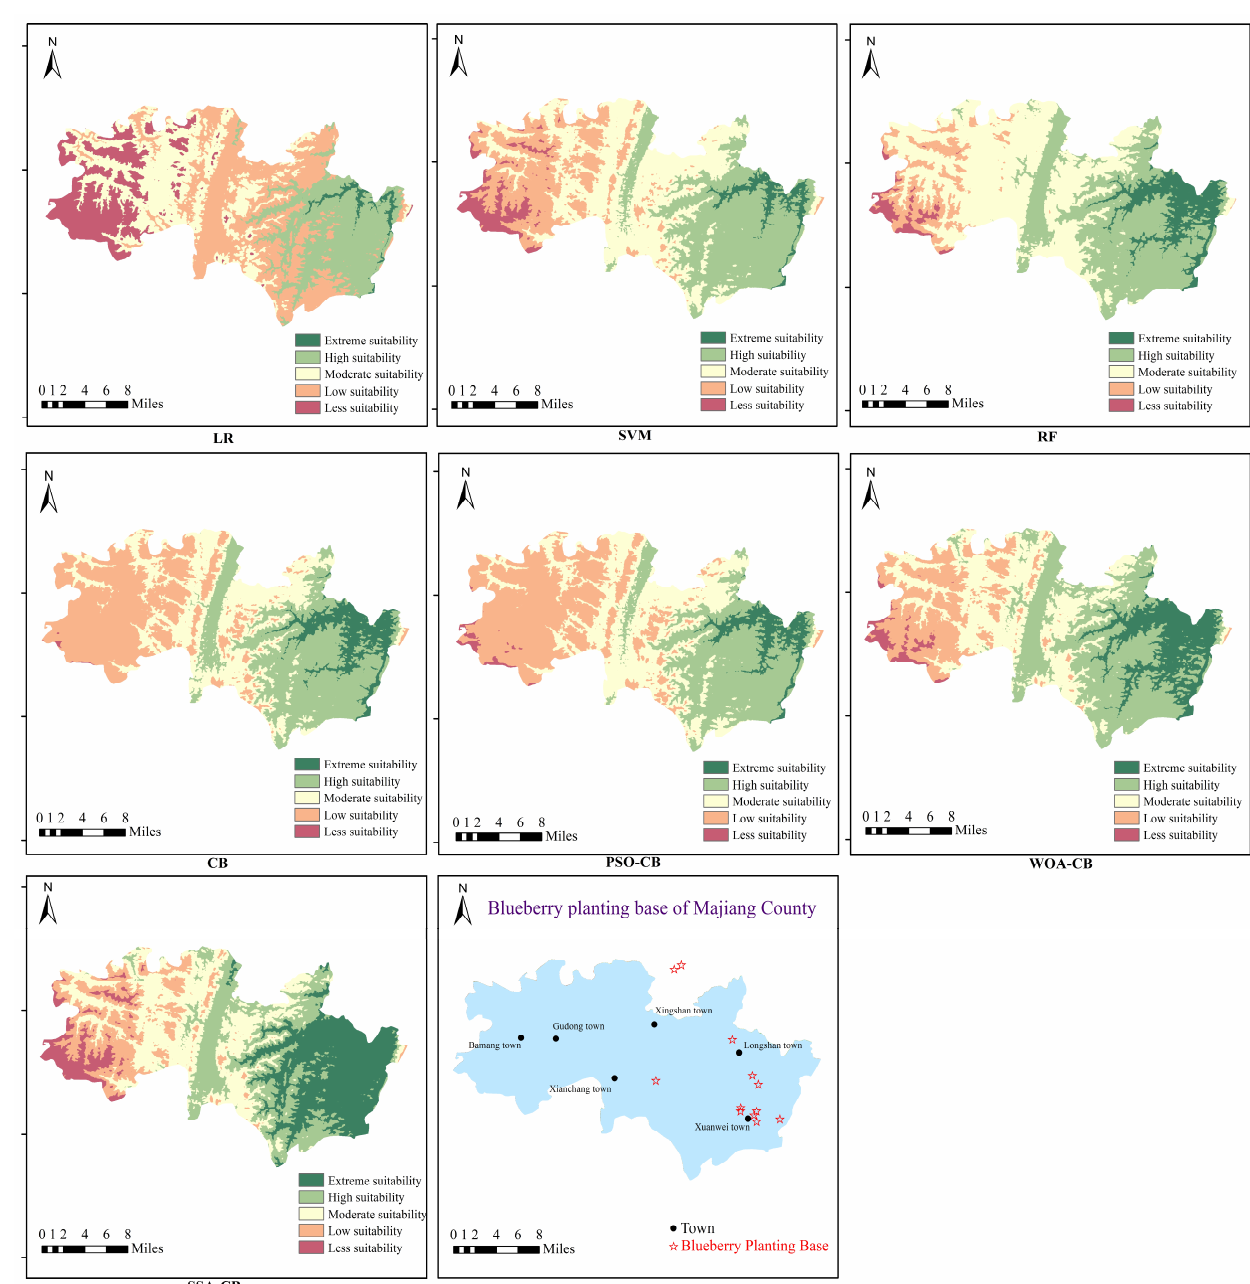
Figure 14. Ecological suitability evaluation map of blueberry in Majiang County with different mod-